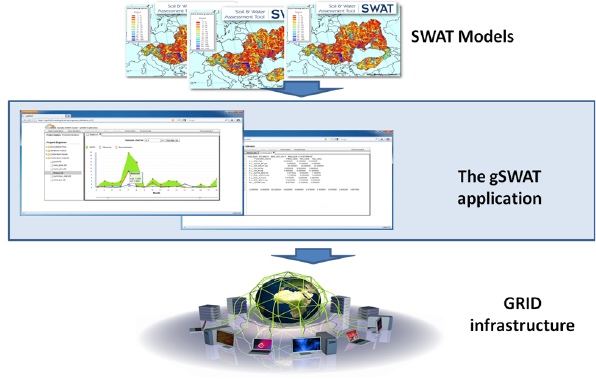
Fig. 3. gSWAT application